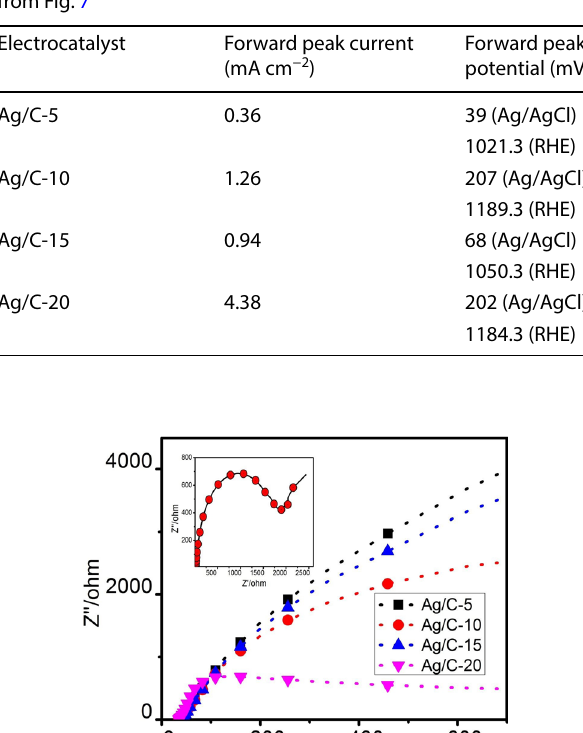
Table 3 Forward peak currents and corresponding peak potentials from Fig. 7 Electrocatalyst Forward peak current (mA cm −2 )